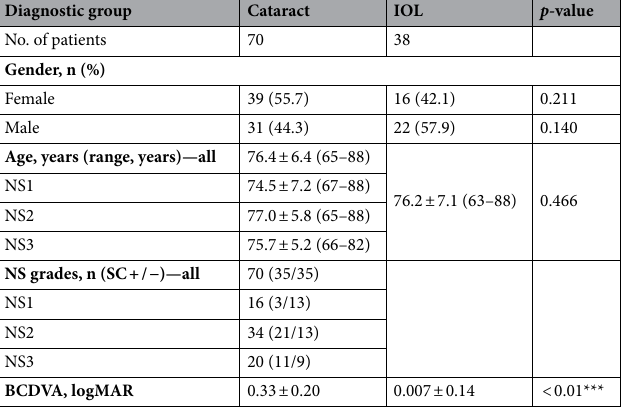
Table 1. Patient demographics. Data are mean ± s.d. unless otherwise indicated. ***Mann–Whitney U-test. BCDVA best-corrected distance visual acuity, IOL intra-ocular lens, logMAR logarithm of the minimum angle of resolution, NS nuclear sclerosis (Emery–Little classification), SC anterior and/or posterior subcapsular cataract, s.d. standard deviation.